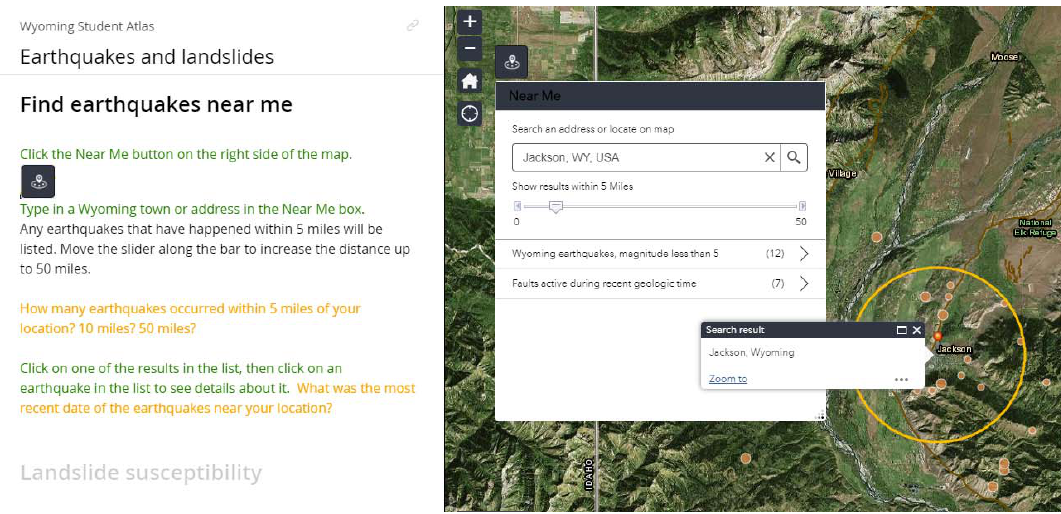
Figure 2. Screenshot of a page from an atlas story map prompting students to locate a place of interest to them on the map and explore features near their location that are related to the story map theme.